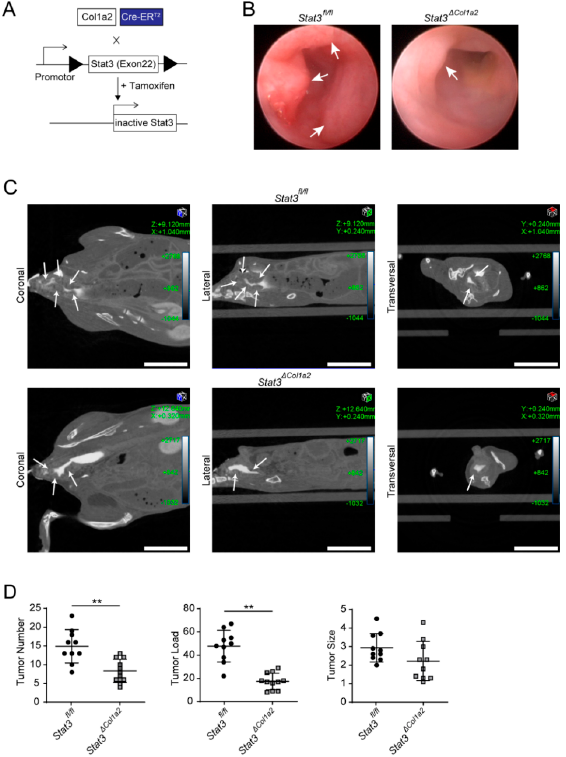
Figure 4. STAT3 inactivation in type I collagen-expressing fibroblasts reduces inflammation-associated experimental tumorigenesis. ( A ) Schematic illustration of the Cre/loxP-based approach to conditionally target STAT3 inactivation in COL1+ cells by cross-breeding of Col1a2 -CreER T2 with Stat3 fl/fl mice. Tamoxifen-induced expression of Cre recombinase results in the deletion of exon 22 (encoding the tyrosine residue (Y705) critical for STAT3 activation), resulting in a STAT3 protein that can no longer be activated. Triangles highlight loxP sites. ( B ) Tumorigenesis in the AOM/DSS model was analyzed in Stat3 ∆ Col1a2 mice and Stat3 fl/fl controls by mini-endoscopy at day 62. ( C ) Tumor growth in the AOM/DSS model was studied in Stat3 ∆ Col1a2 mice and littermate controls by contrast- agent-enhanced micro-CT and presented in coronal, sagittal and axial planes. Arrows point to colon tumors. Scale bar: 10 mm. ( D ) Tumor number, tumor load and tumor size (mm) of AOM/DSS-treated Stat3 ∆ Col1a2 mice ( n = 11) and littermate controls ( n = 12) were measured ex vivo at day 64. The results are at least of two independent experiments. Quantitative data are shown as mean values ±